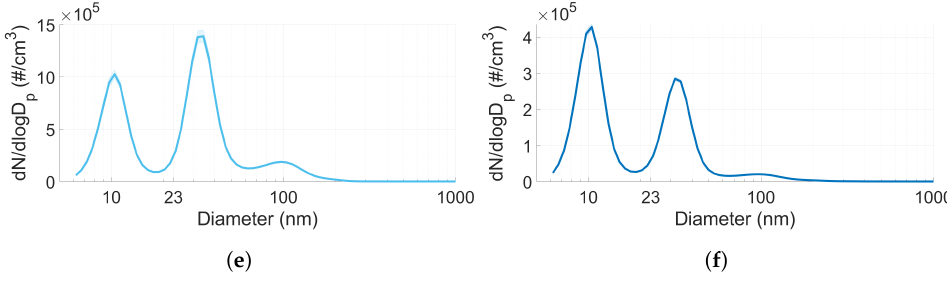
Figure 8. The total particle size distribution for particle emissions for ( a ) gasoline, ( b ) MTBE, ( c ) ethanol, ( d ) methanol, ( e ) n-butanol and ( f ) iso-butanol at 3500 RPM and 13 bar IMEP. The shad- owed areas show the normalised random error ( ± (cid:101) ).